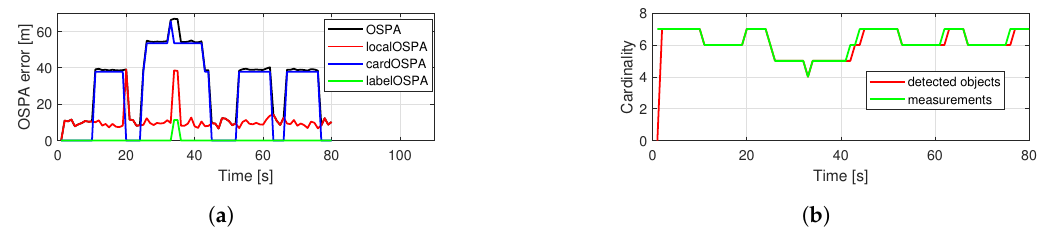
Figure 8. Performance of a single simulation with random trajectories using the basic PHD filter. OSPA error ( a ), cardinality statistics ( b ).